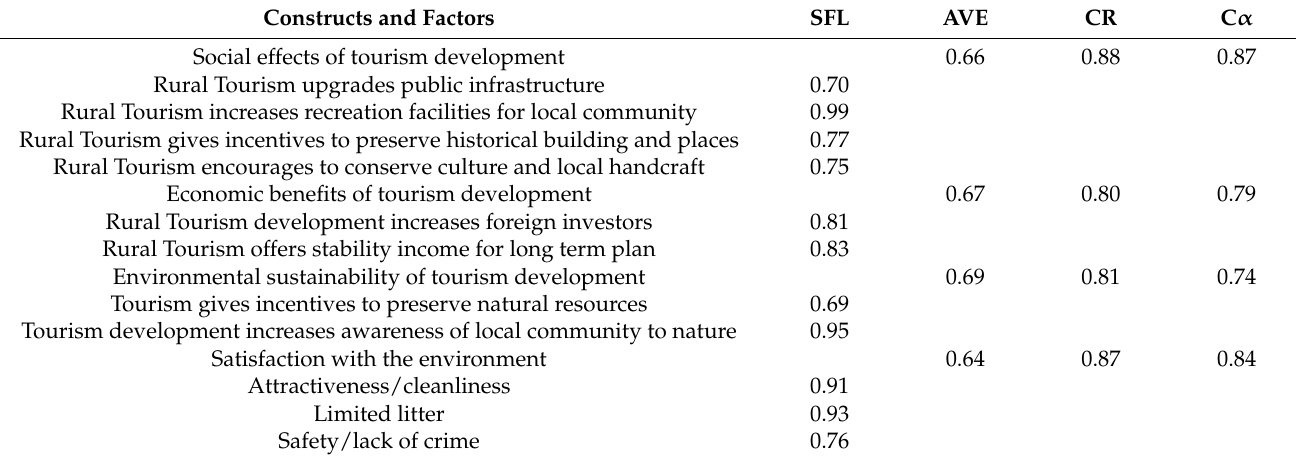
Table 2. The outcomes of the confirmatory factor